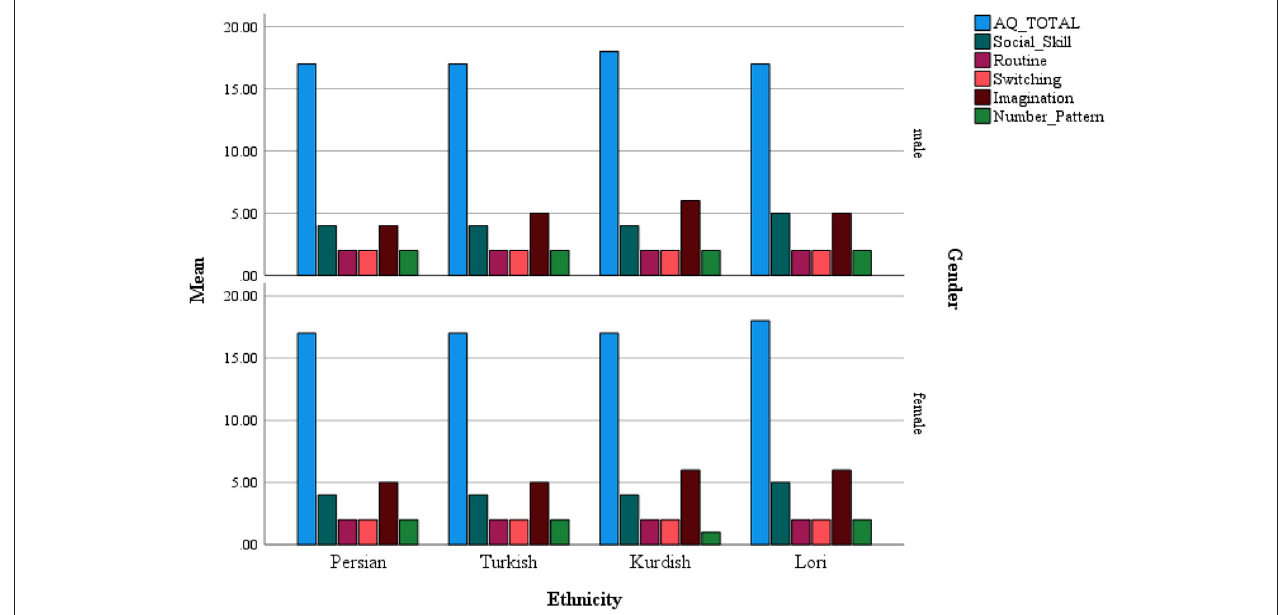
FIGURE 1 | Distribution of AQ scores across ethnicities for males and